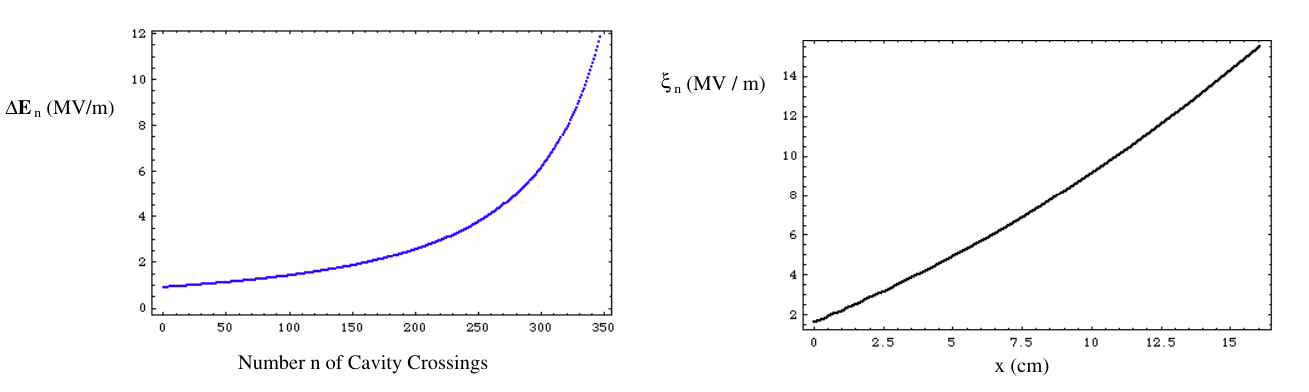
versus radial beam posi- n